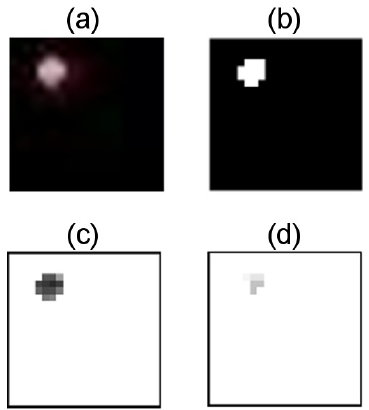
Figure 8. Cropped Image Process. ( a ) ROI of the image with LED1 turned on in red color; the distance between emitter and receiver was set to 100 cm; ( b ) Binary mask obtained with threshold 0.3431; ( c ) Non-zero pixels of the emitting LED’s image, obtained from applying the mask to channel R of the image; ( d ) Non-zero pixels of the interference signal from LED2 turned on in white color, obtained from applying the mask to channel R of the interference image.